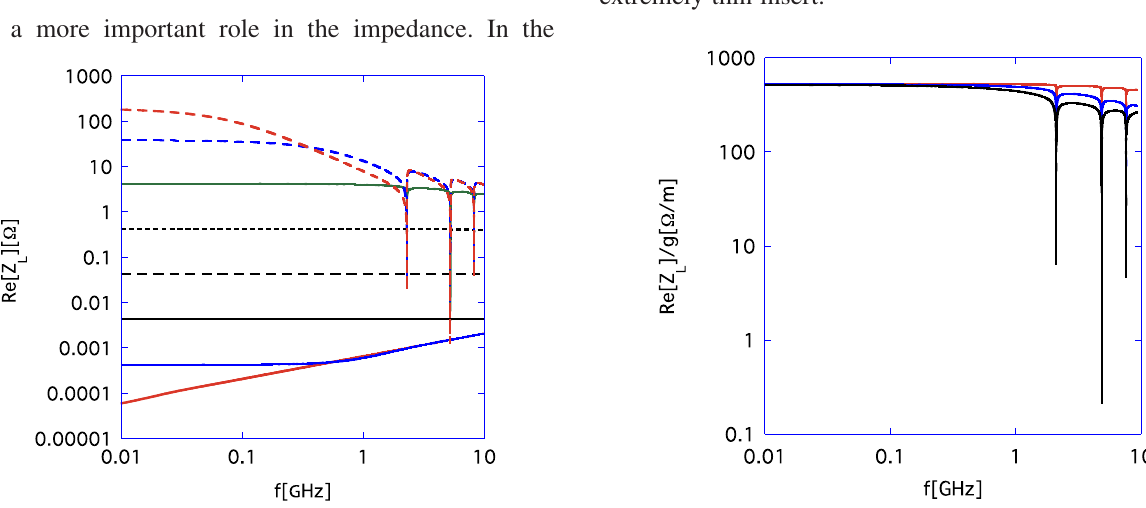
FIG. 5. (Color) The longitudinal impedances per a unit length for the case that the thickness of the insert t is equal to 1 nm and Lorentz factor (cid:6) is equal to 1000. The red, the blue, and the black lines show the cases that the length of the insert g is equal to 2, 8, and 18 mm, respectively. The impedance itself (not normalized ffiffiffi p g , while it is by the gap length g ) is proportional to in f > f c proportional to g in f (cid:4) f c